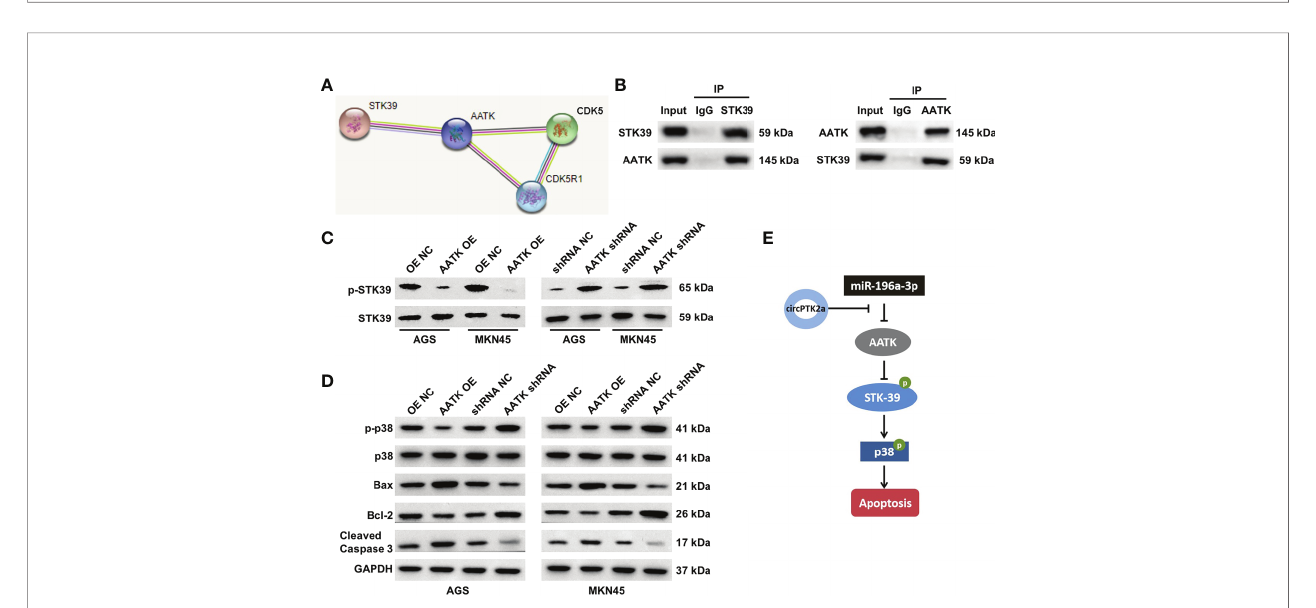
FIGURE 8 | AATK interacts with STK39 and modulates the phosphorylation of p38. (A) Protein – protein interaction network of AATK. (B) Co-IP was performed to evaluate the interaction between AATK and STK39. (C) Western blot analysis of p-STK39 and STK39 protein expressions in AGS and MKN45 cells transfected with AATK-OE or AATK shRNA. (D) Western blot analysis of p-p38, p38, Bax, Bcl-2, and cleaved caspase 3 protein expressions in AGS and MKN45 cells transfected with AATK-OE or AATK shRNA. (E) The potential mechanism by which circPTK2 regulated the progression of gastric cancer was